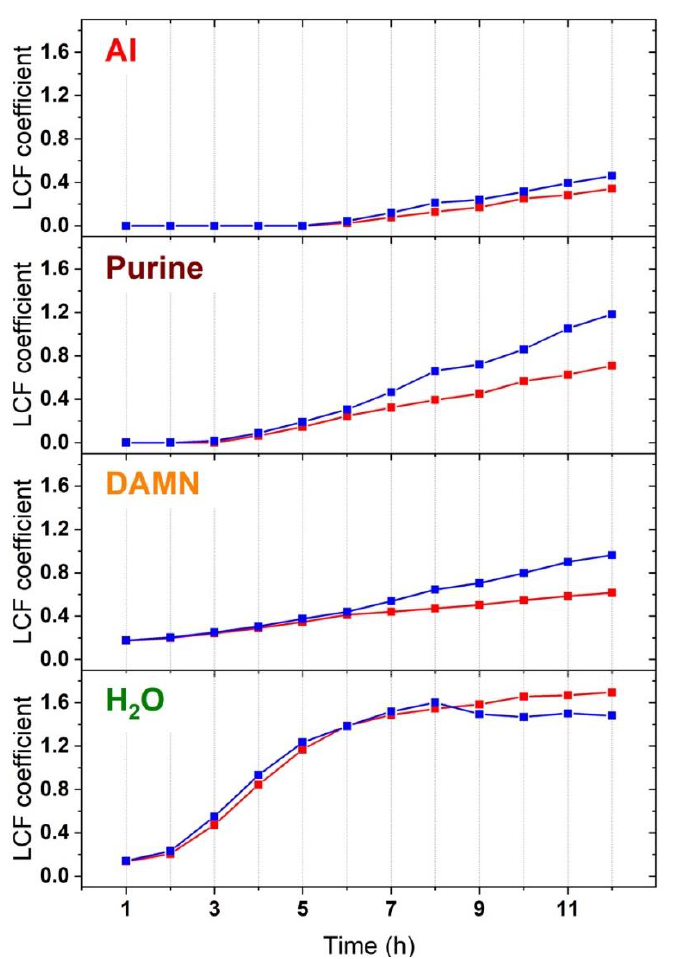
Figure 4. LCF coefficients vs. time of molecules formed during formamide reaction (H 2 O, DAMN, Purine and AI), derived from datasets reported in Figure 2, as measured during 12 h of reaction of formamide at 160 °C on amorphous SiO 2 (Aerosil OX50): as such (red); and calcined at 450 °C (blue).